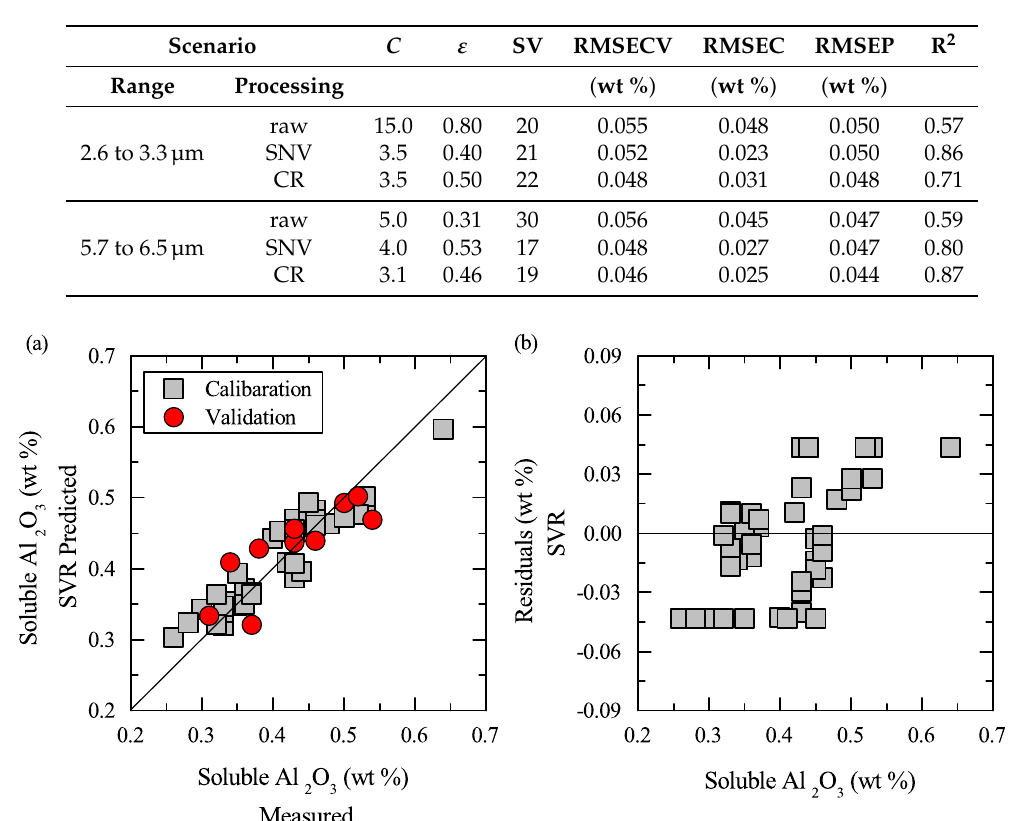
Figure 8. ( a ) Measured vs. Predicted plot of the PLS-R model for the 5.7 to 6.5µm range after SNV processing, including K 2 O, Fe 2 O 3 , and MgO as variables. LV = 2 in the calibration and validation samples. ( b ) Residuals plot of the PLS-R calibration. Table 4. Summary of the optimisation parameters and performance indicators of the best support vector regression (SVR) calibrations.